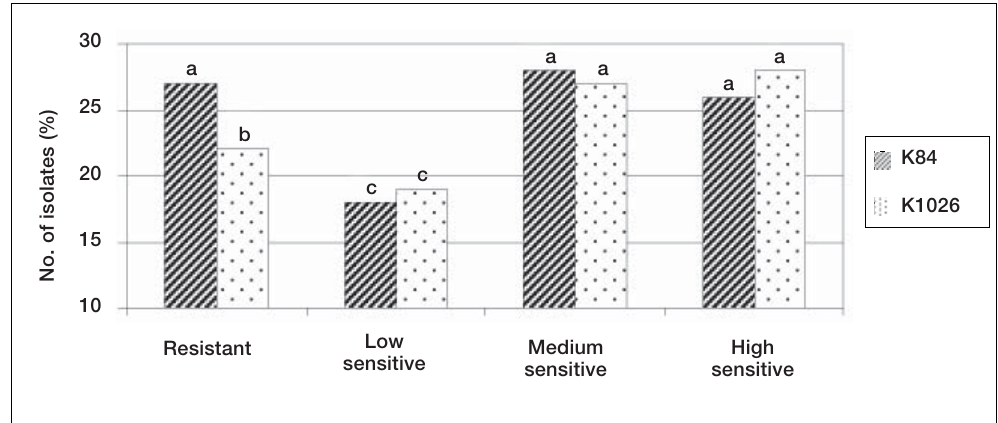
=0.05.Fig. 1. Distribution of the isolates according to their sensitivity to Agrobacterium radiobacter strains K84 and K1026. Bars with the same letters are not significantly different at P